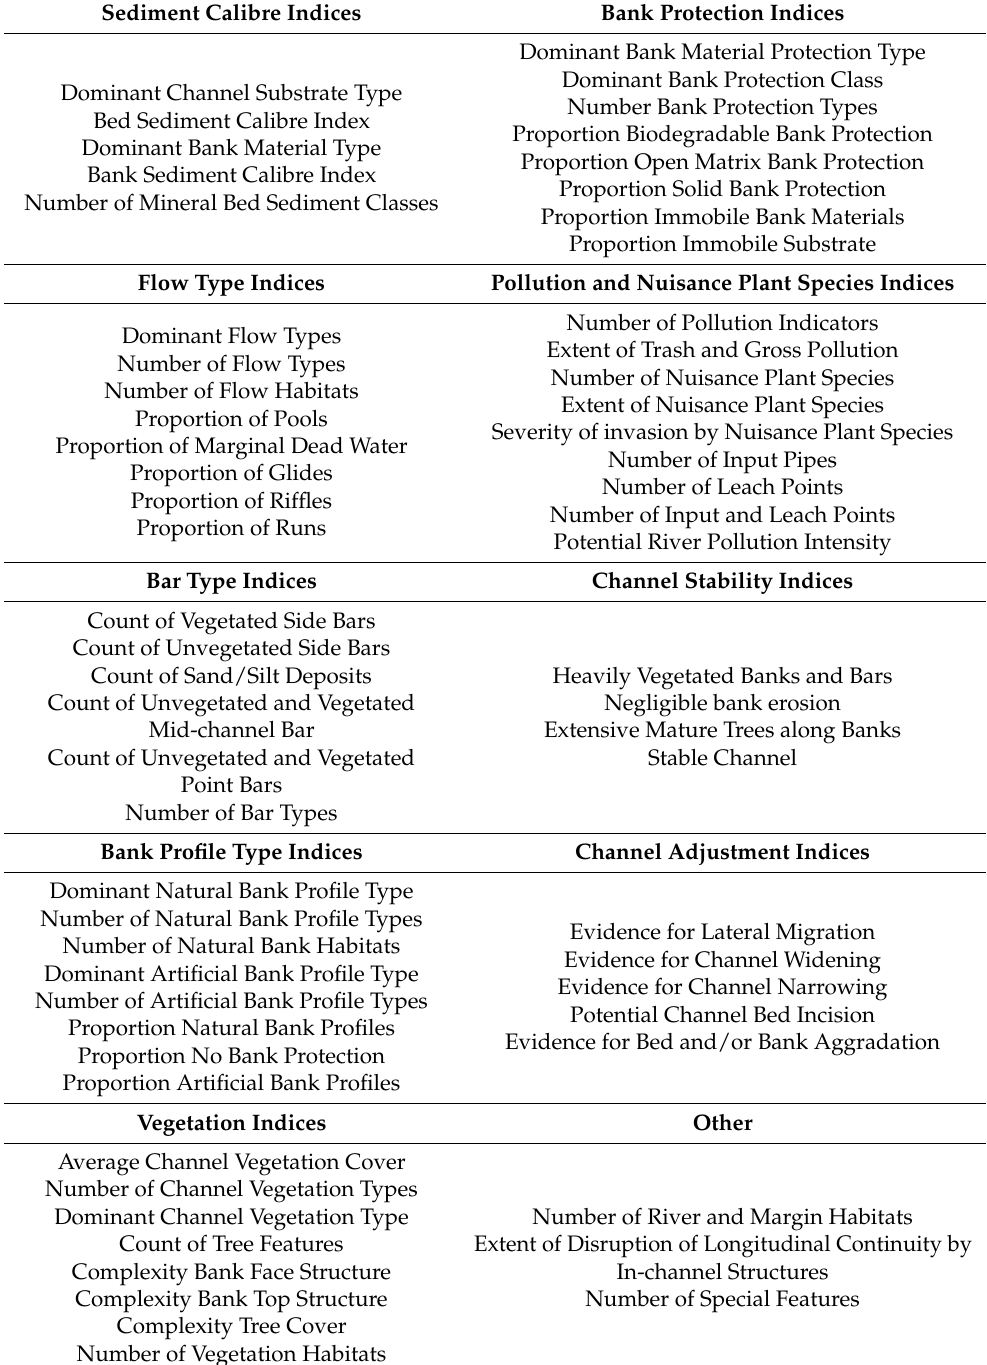
Table 2. PlaceMarker River Survey